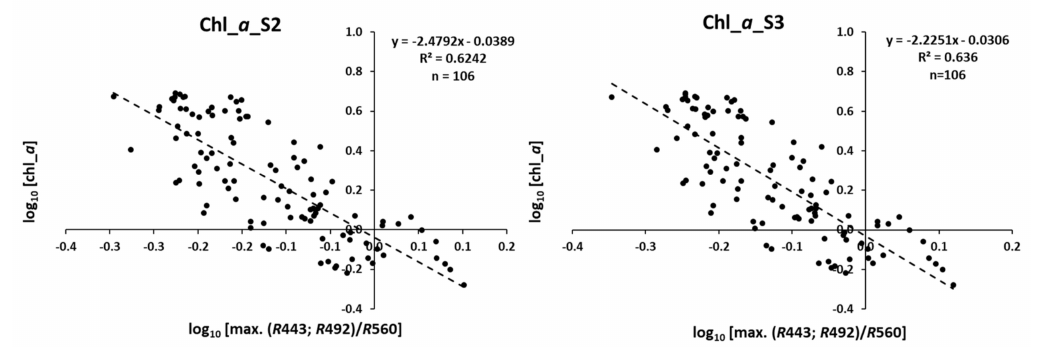
Figure 8. Chl_a algorithms recalculated using all data under 5 mg/m 3